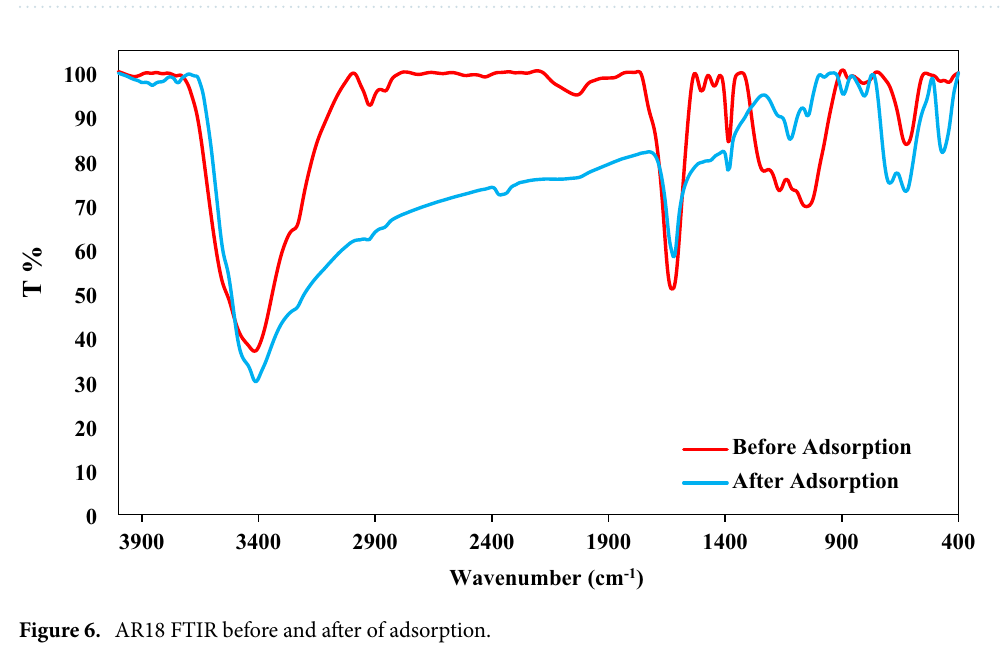
Figure 5. GFH EDS spectrum.